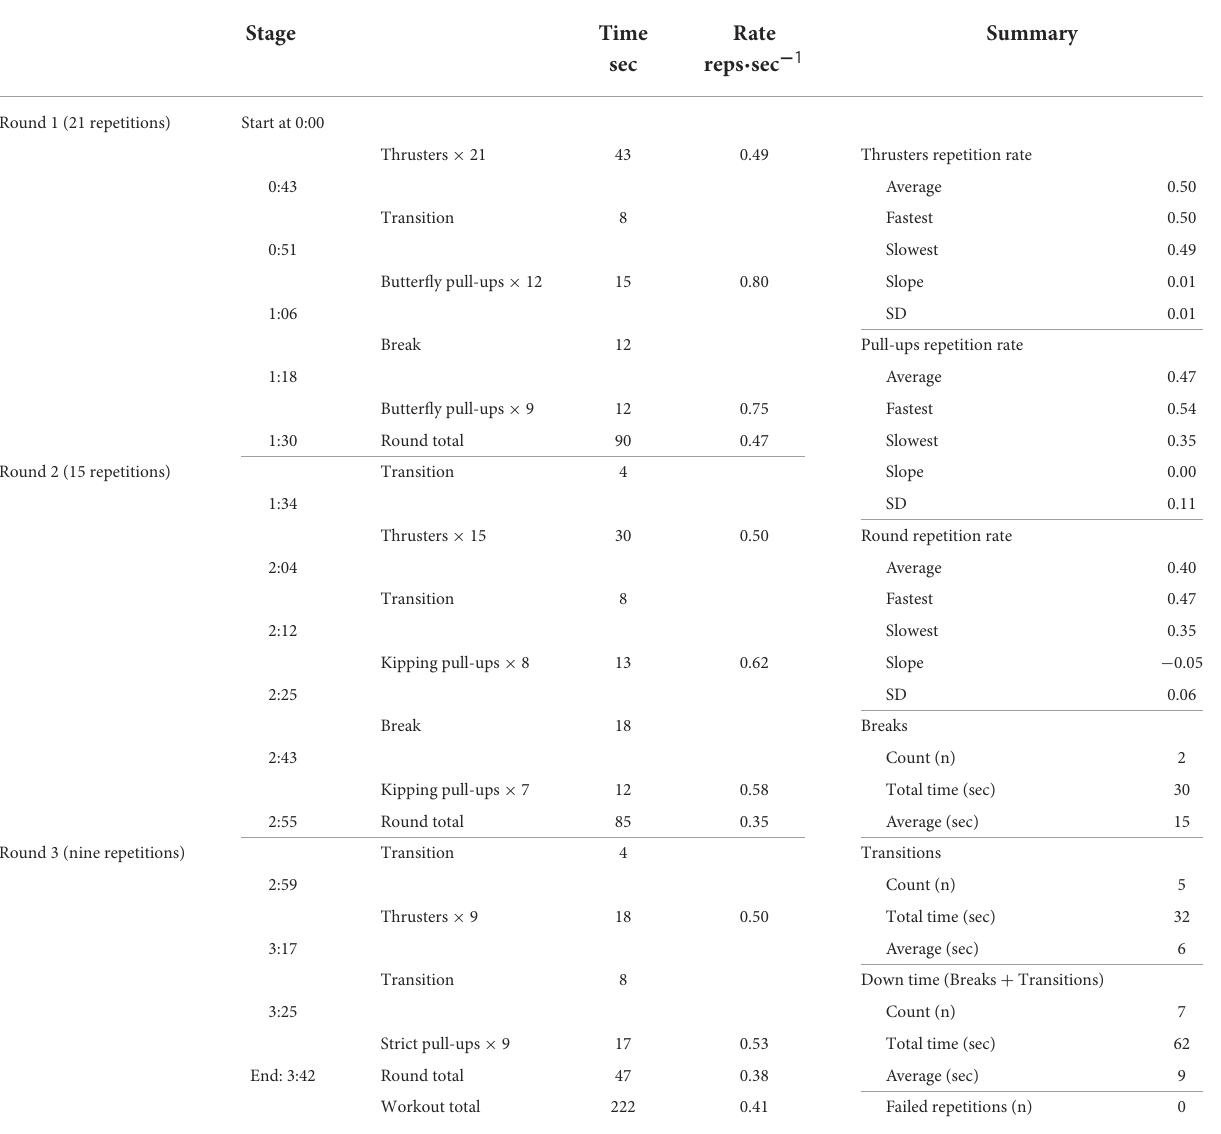
TABLE 3 Repetition and round completion rate for thrusters and pull-ups in the benchmark workout “Fran.” Stage Time Rate Summary − sec reps · sec